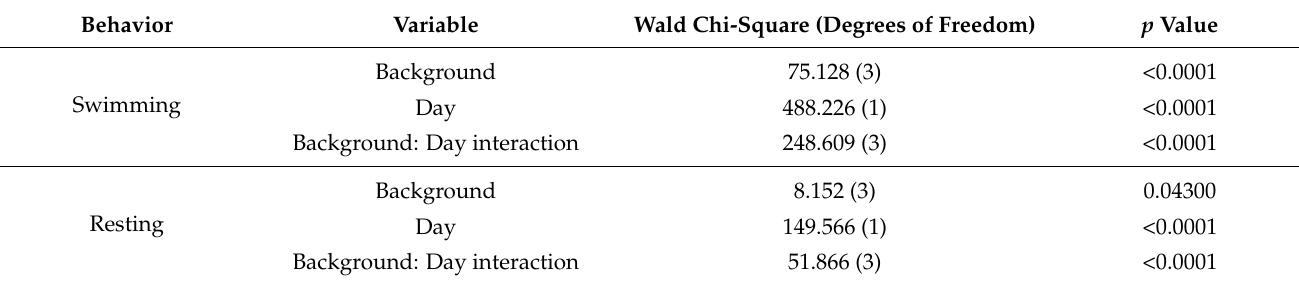
Table 2. The results of the analysis of deviance analysis for both swimming and resting models.